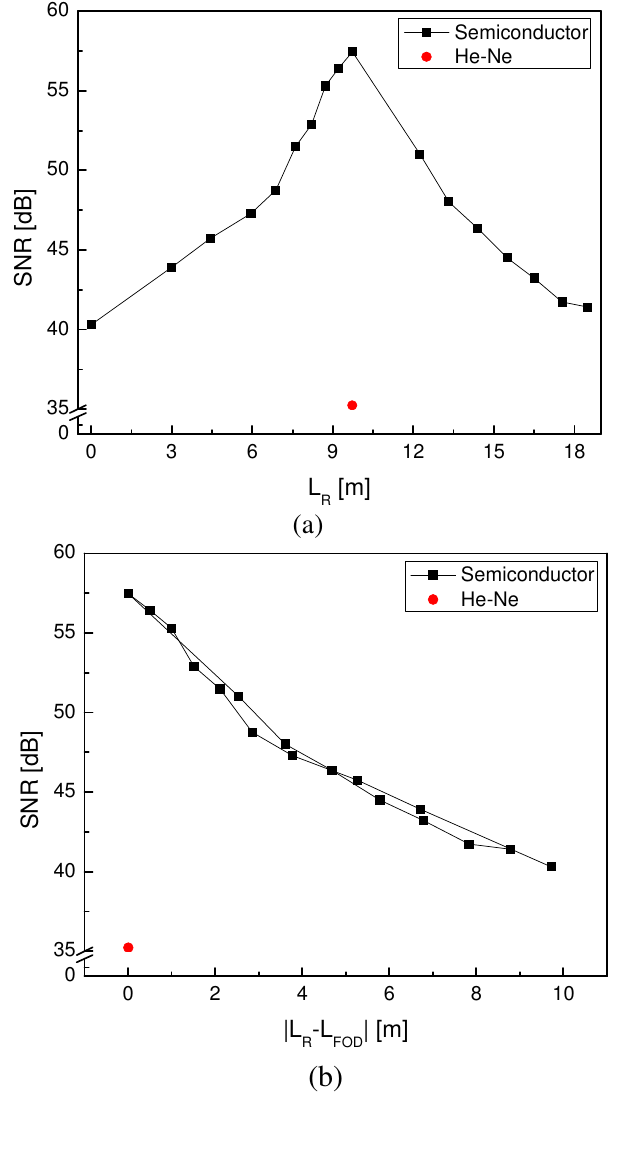
Figure 4. (a) SNR of guided wave signal changes with the optical fiber length of reference light of semiconductor interferometer. (b) SNR of guided wave signal changes with the absolute difference between optical fiber lengths of reference light and signal